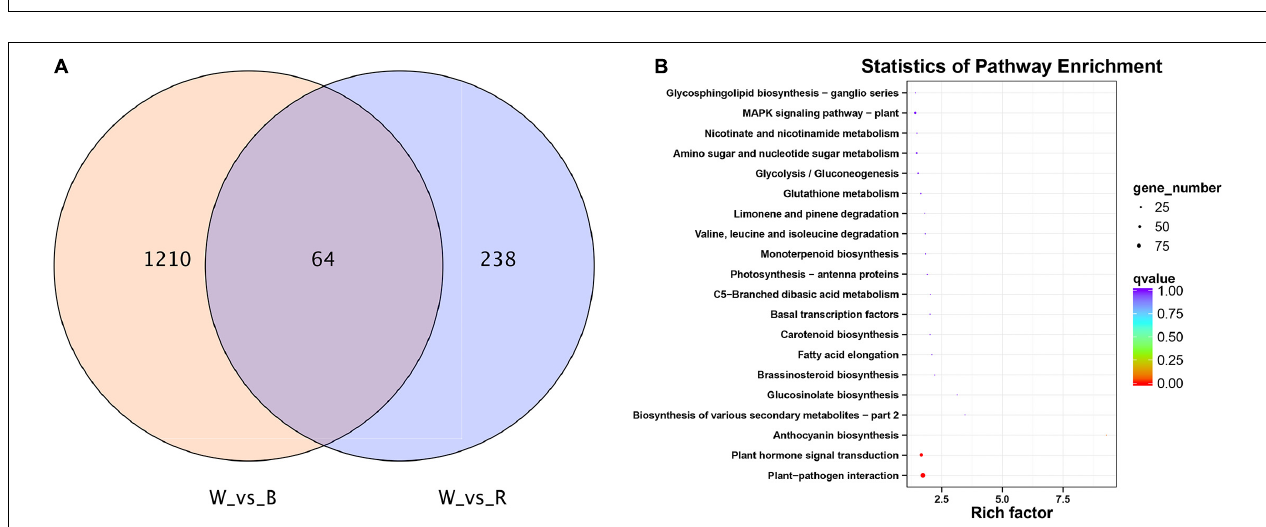
FIGURE 3 | (A) VENN diagram showing the number of differentially expressed genes (DEGs) per comparison between different light quality in mature leaves. (B) Top 20 statistics of KEGG pathway enrichment in mature leaves under 3 light